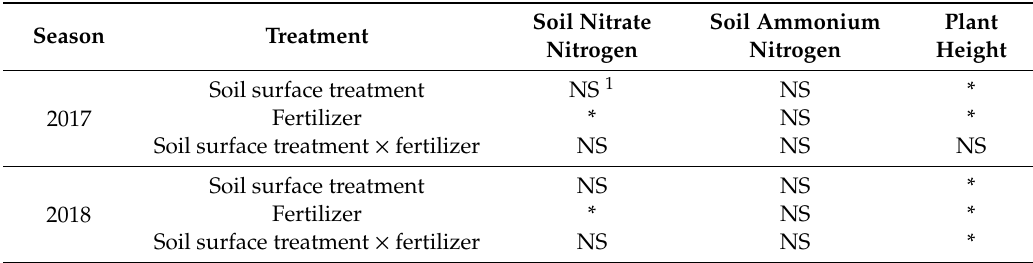
Table 2. E ff ect of di ff erent treatments on soil nitrate nitrogen, soil ammonium nitrogen and plant height were analyzed by analysis of variance in 2017 and 2018 using